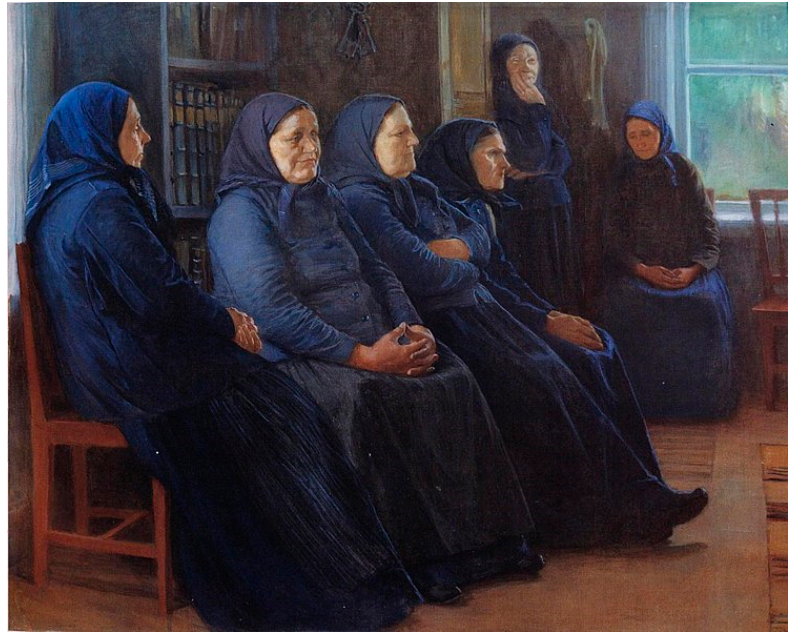
Figure 4. Venny Soldan-Brofeldt (1863–1945): Heränneitä, 1898. Collection: Ateneum (the Finnish National Gallery).